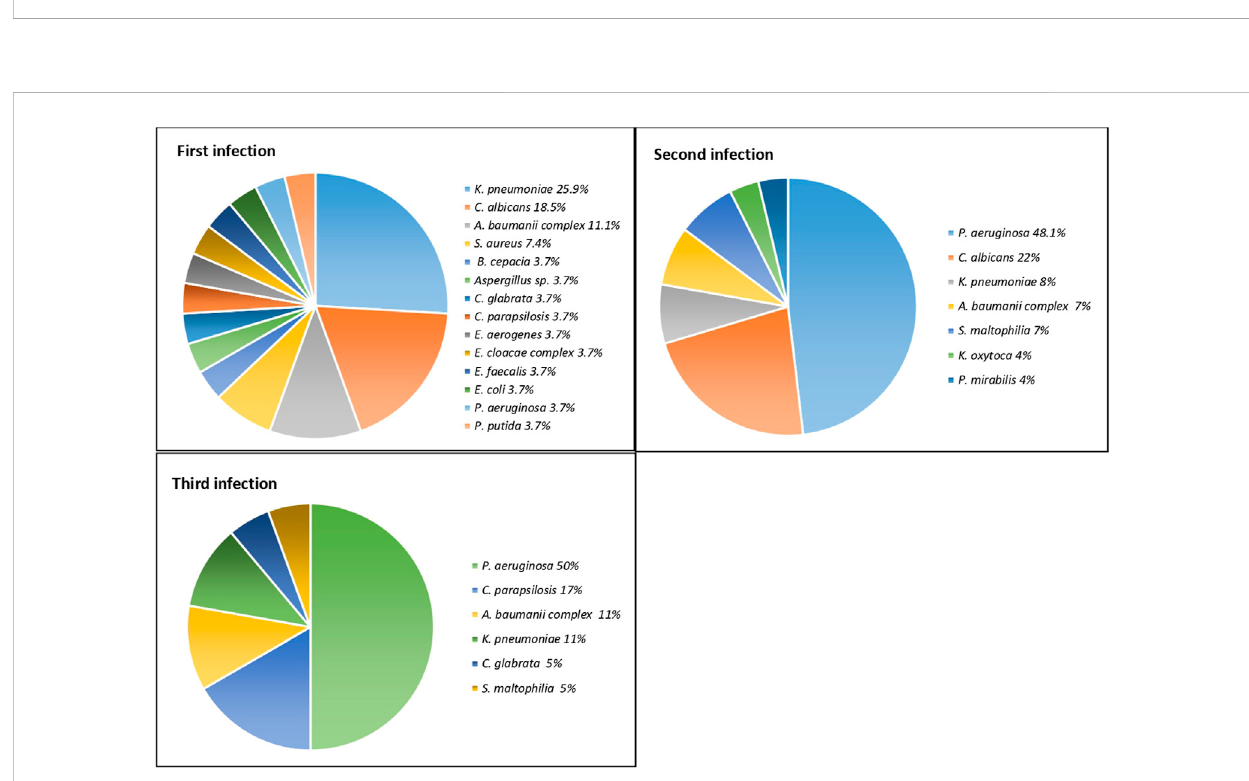
Microorganisms isolated during the three coinfection events. All Klebsiella pneumoniae strains belonging to the ssp. pneumoniae